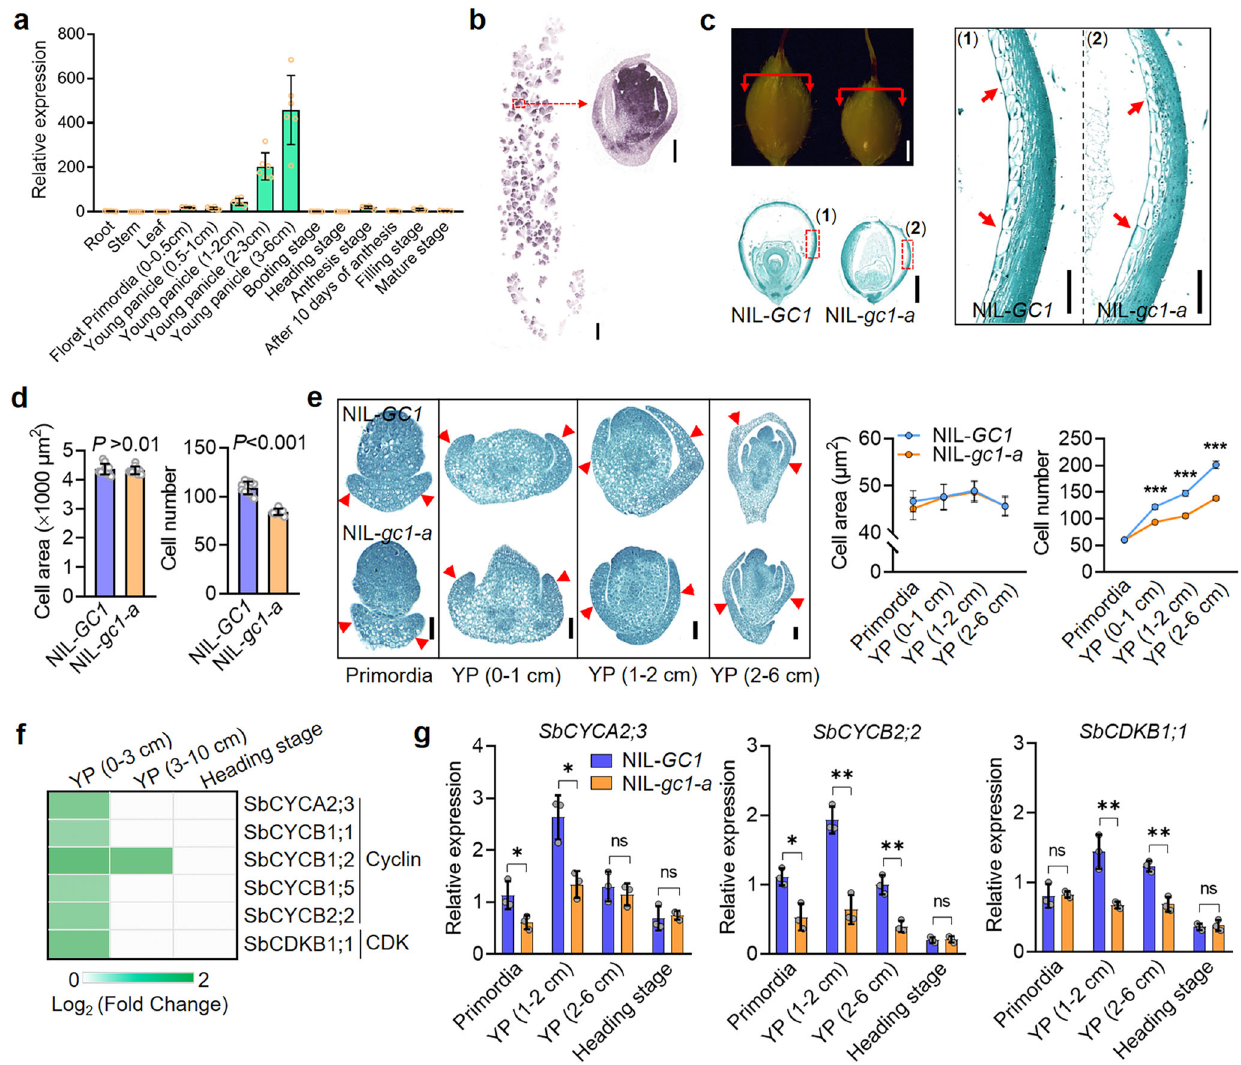
Fig. 4 gc1-a induces low glume coverage by repressing cell proliferation. a Spatio-temporal expression pattern of GC1 . Data are mean ± s.e.m. n = 6 biological replicates. b RNA in situ hybridization of GC1 in NIL- GC1 at 3 cm young panicle stage. Left bar = 2 mm. Right bar = 200 μ m. c Longitudinal paraf fi n-section of glumes in NIL- GC1 and NIL- gc1-a at fl owering stage. Bar = 1mm. Magni fi ed glume cell morphology in NIL- GC1 and NIL- gc1-a . Bar = 200 μ m. d Statistics of glume cell area and cell number in NIL- GC1 and NIL- gc1-a . e Longitudinal paraf fi n-section of glumes in NIL- GC1 and NIL- gc1-a at four young panicle developmental stages. YP Young panicle. Bar = 200 μ m. The red arrows show corresponding glume cells. Statistical data in d and e are mean ± s.e.m. n = 10 biological replicates. P- values were determined by two-tailed unpaired t -test. ***Signi fi cant probability level at P < 0.001. f Heatmap of downstream DEGs of GC1 related to Cyclin-CDK pathway. Fold change was calculated for NIL- GC1 samples compared with NIL- gc1-a samples. g Relative gene expression of Cyclin-CDK related genes SbCYCA2;3, SbCYCB2;2 and SbCDKB1;1 at four panicle stages. Data are mean ± s.e.m. ns not signi fi cant. Three biological repeats were performed. P- values were determined by multiple two-tailed unpaired t -test. *Signi fi cant probability level at P <0.05. **Signi fi cant probability level at P <0.01. Source data are provided as a Source Data fi